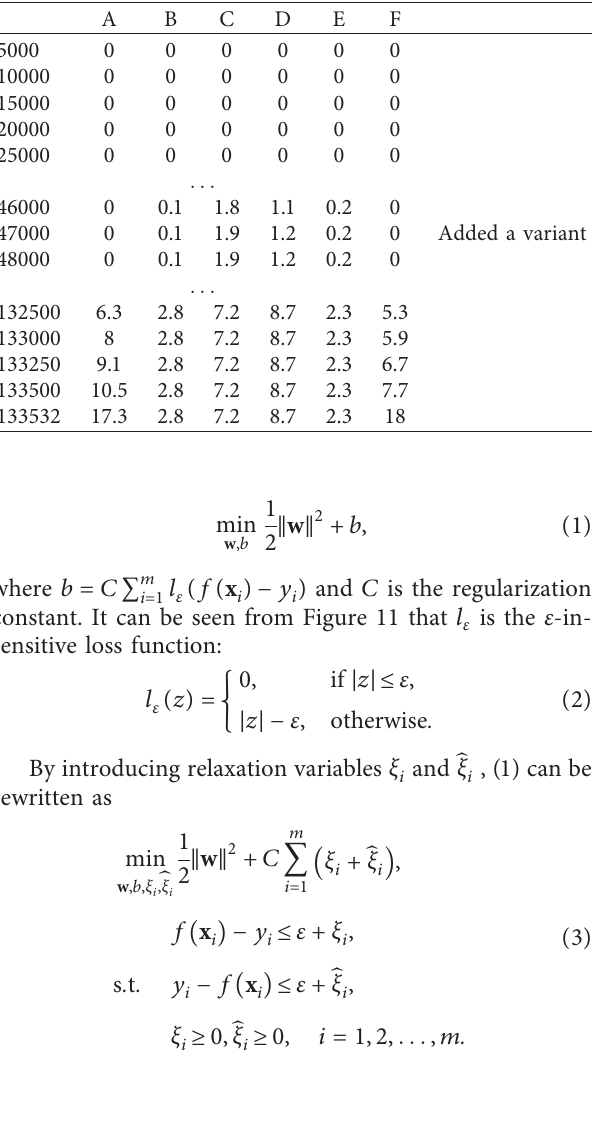
Table 9: Partial test data of variable amplitude three-hole test